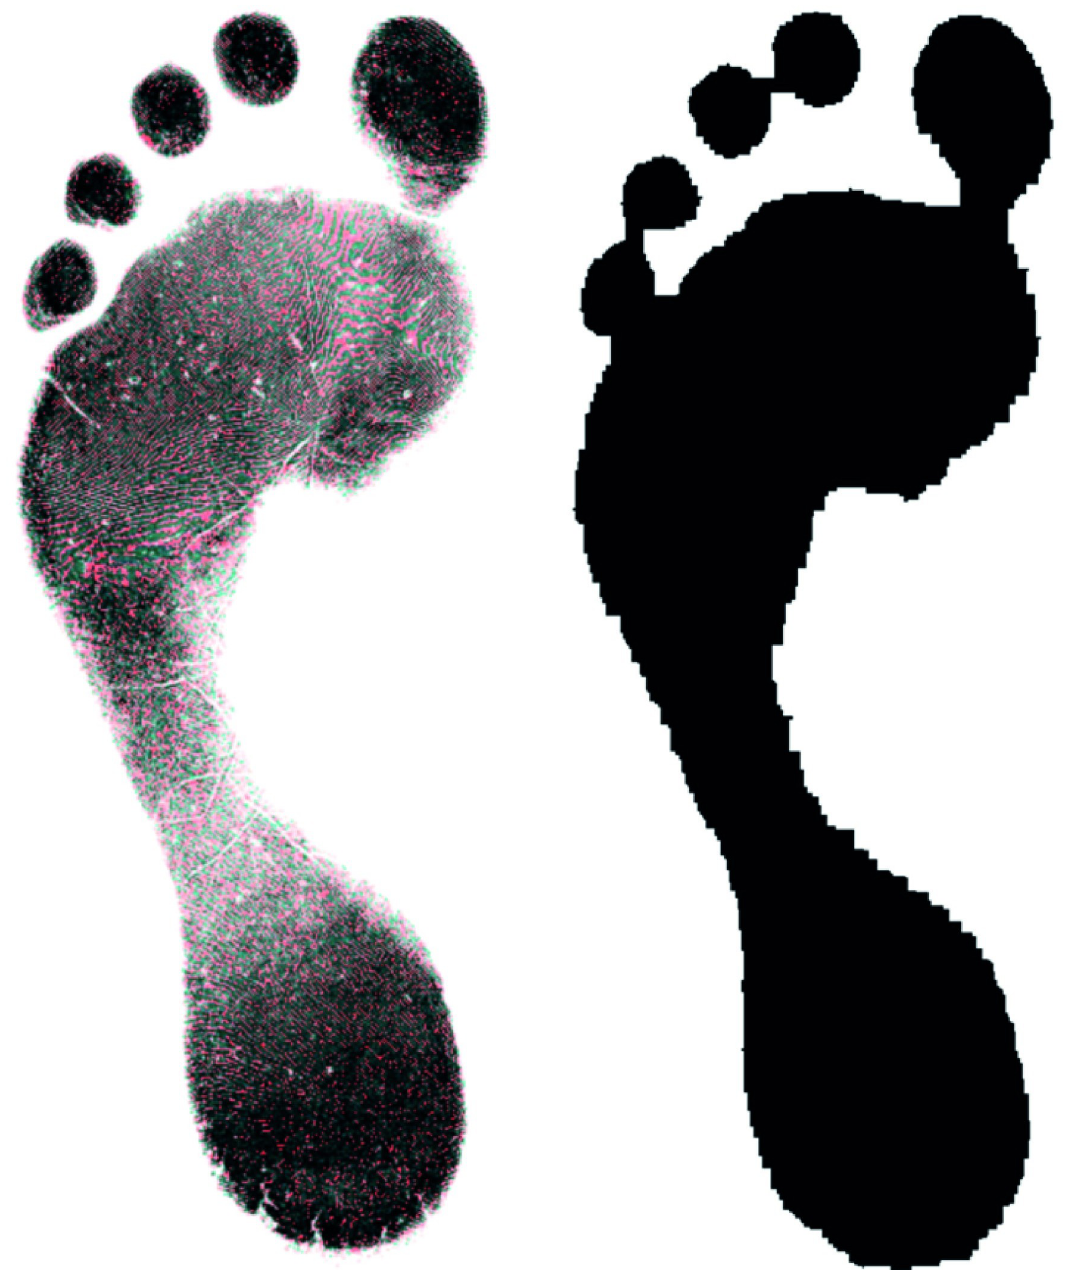
Fig 3. Image analysis. A. Image with channels composed using 3 resizing methods (R = NEAREST, G = BILINEAR, B = HAMMING). B. The same print with ridge detail removed using dilation operation followed by erosion